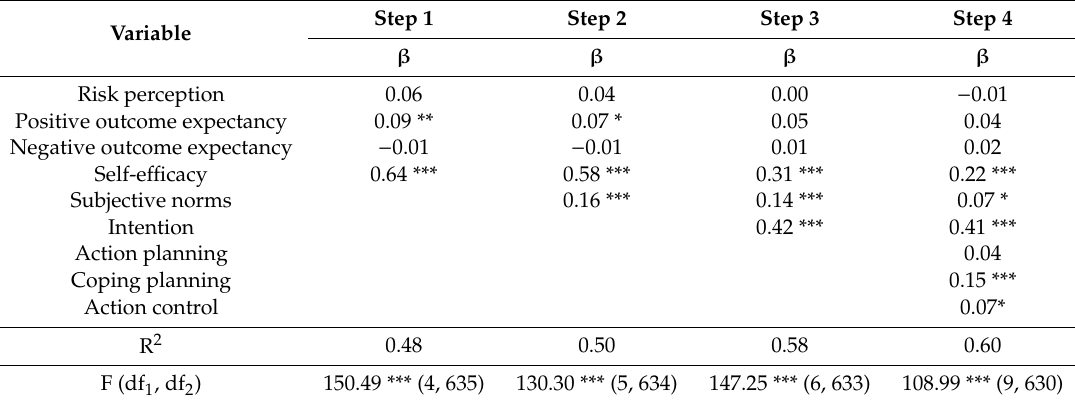
Table 3. Summary of hierarchical regression analysis of variables predicting